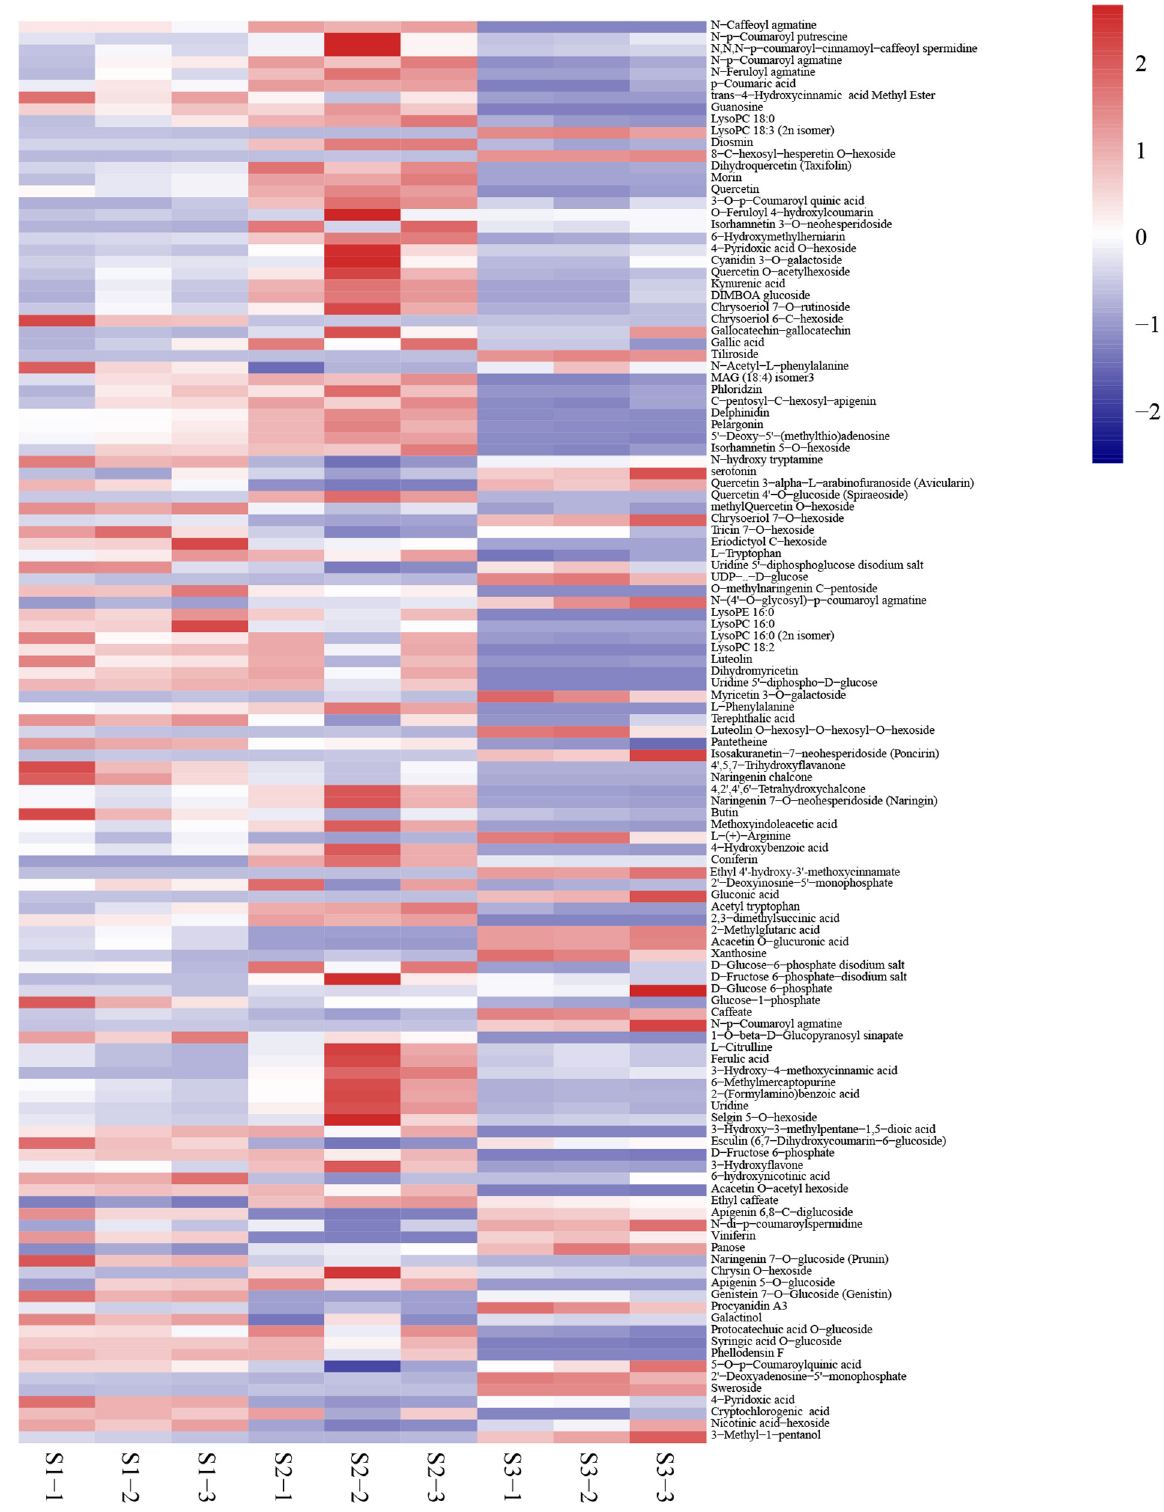
Figure 5: Heat map of the di ff erential metabolites at three di ff erent foliar